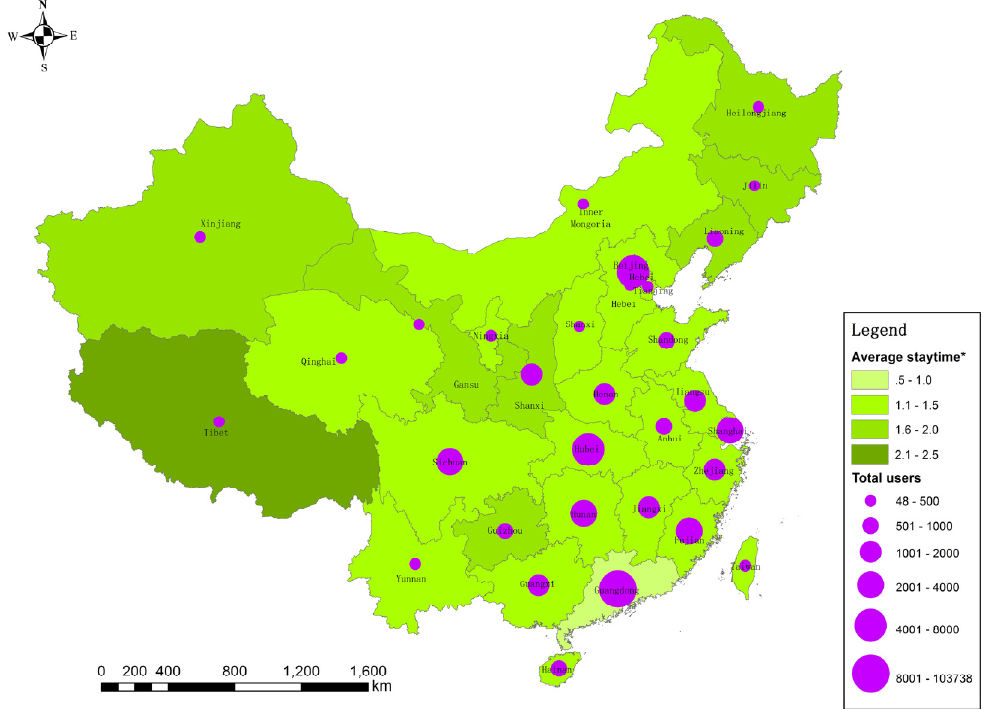
Figure 2. Origin and number of nonlocal tourists who remained in Shenzhen for ≤ 15 days. Background green shades represent the average duration of tourists whose check-in duration was less three days.